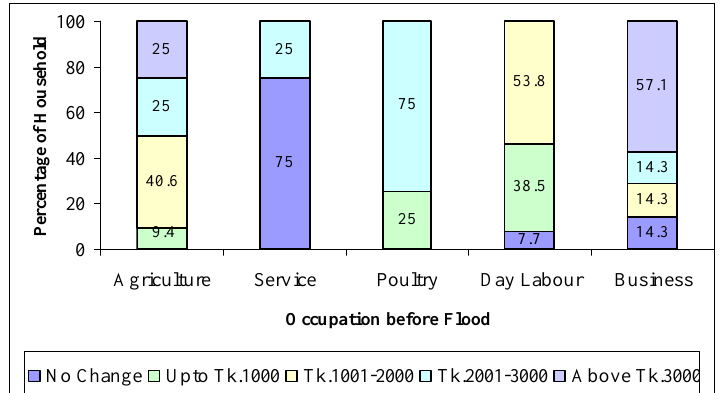
Figure 5. Distribution of households according of occupation before flood and income change (Reduce Income) due to flood. Source: field survey.